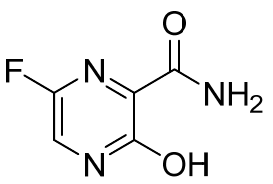
Figure 1. Chemical structure of favipiravir.